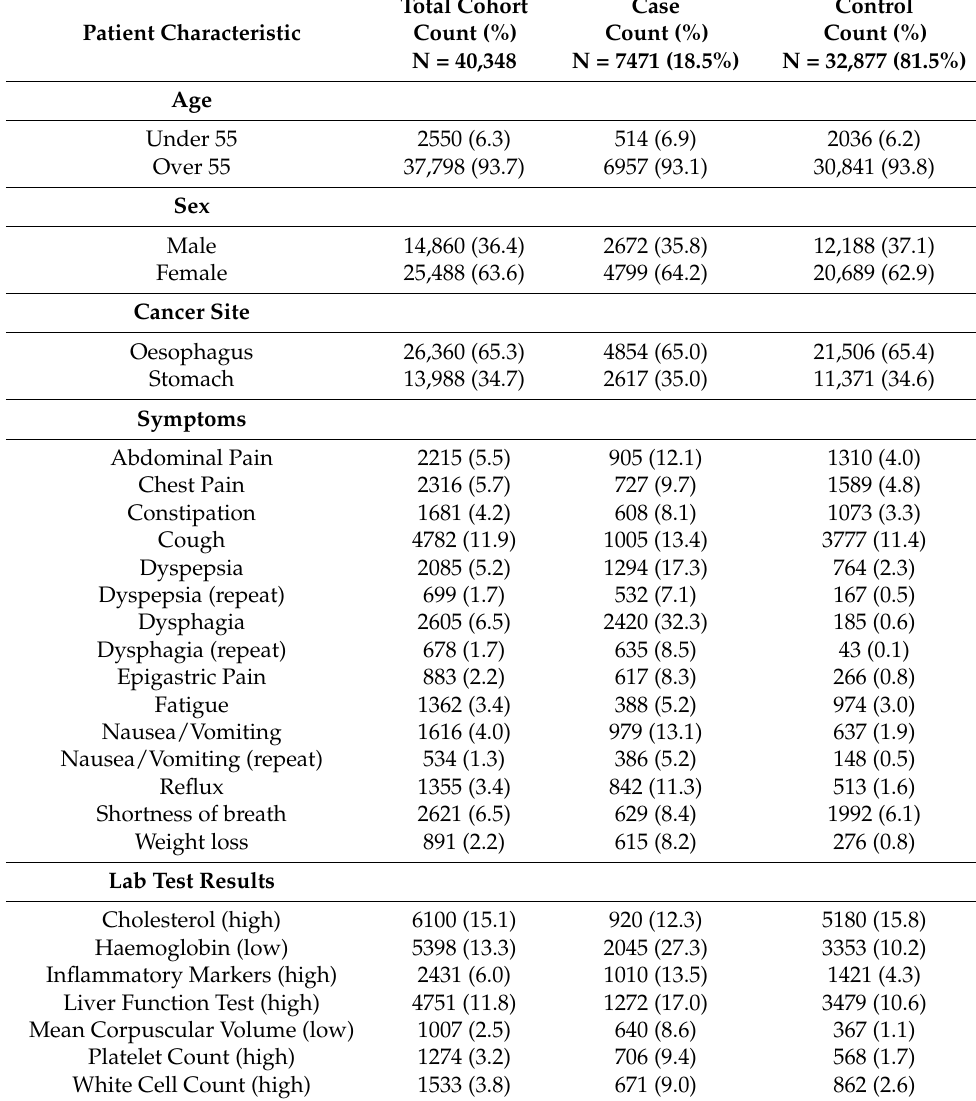
Table 1. Patient characteristics of 40,348 individuals according to basic demographic information, symptoms, lab test results, and cancer site, organised by case/control. Figures given as number of occurrences (in total cohort/case group/control group) and